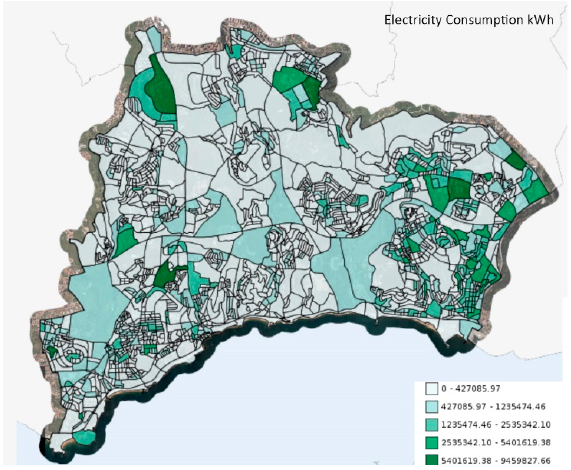
Figure 6. Map of electricity consumption.